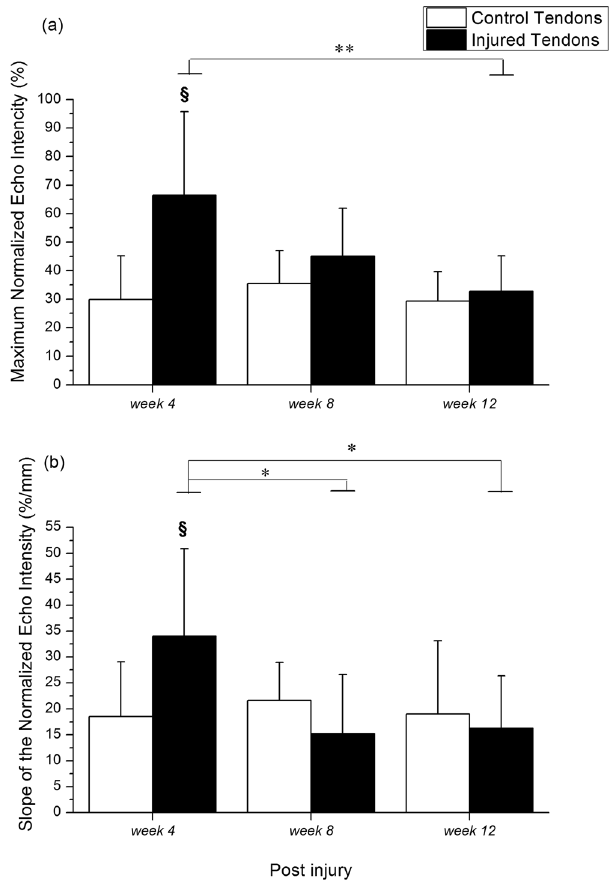
Figure 4. Normalized echo intensity of Achilles tendon. ( a ) Maximum normalized echo intensity, and ( b ) slope of the normalized echo intensity are shown after week 4 , week 8 , and week 12 . § Compared with the control tendons; * / ** compared within the injured tendons; §/ * p < 0.05, ** p < 0.01.